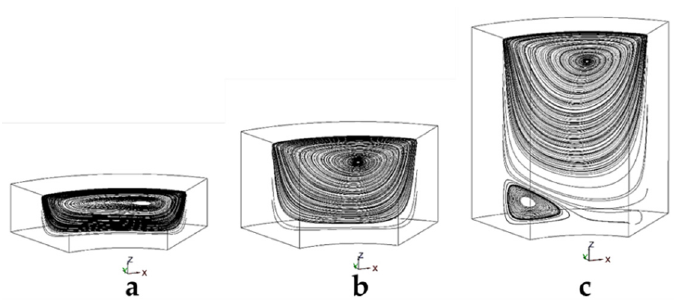
Figure 3. Streamlines of middle plane for different aspect ratios of cavity at Re = 100, Ra = 1e4, φ = 0%; ( a ) HR = 0.5, ( b ) HR = 1, ( c ) HR = 2.